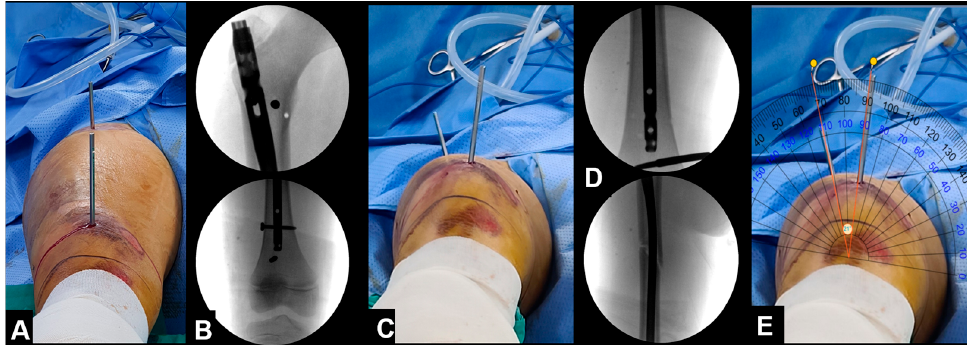
Figure 5. ( A , B ) Parallel Schanz pins placed in the proximal and distal femur; ( C , D ) internal rotation of the distal segment after removal of the distal interlocking screws; ( E ) the smartphone application measured a 20° correction.